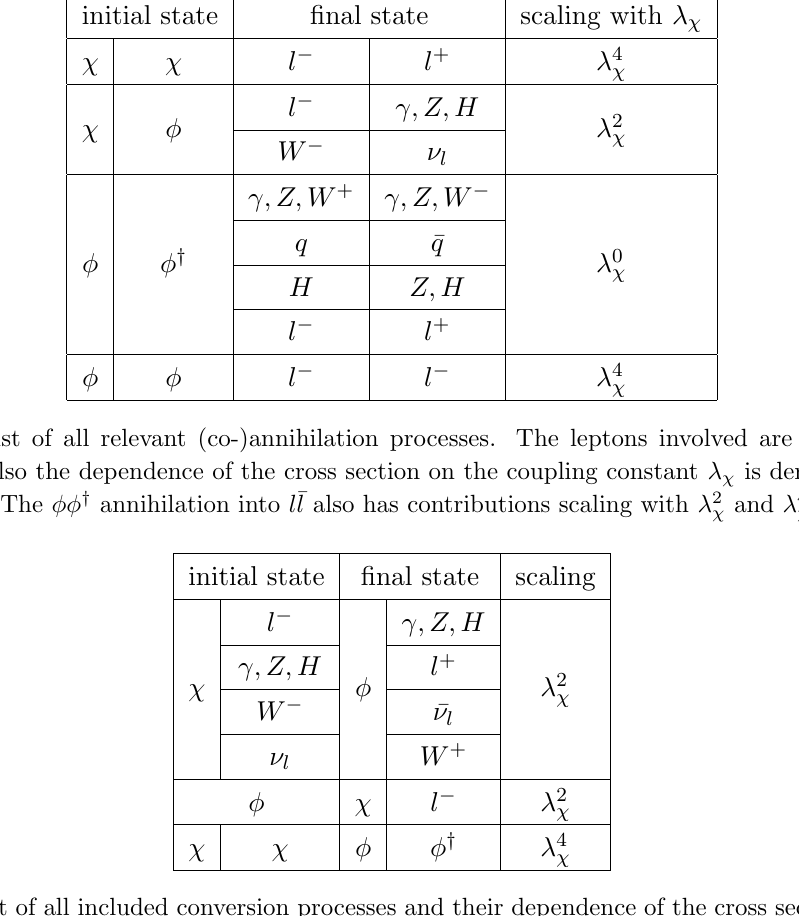
Table 2 . List of all included conversion processes and their dependence of the cross section on (cid:21) (cid:31) . l is one of the leptons ( e; (cid:22); (cid:28) ), depending on the case we are studying. where in the second line we have assumed small mass splittings ((cid:1) m (cid:28) m ) and